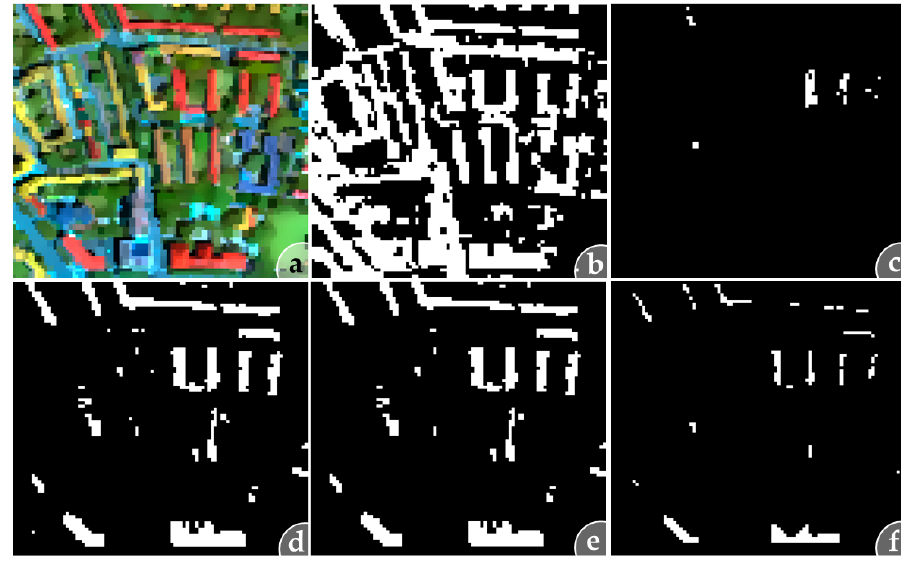
Figure 4. Masking steps to determine unknown artificial pixels for ( a ) a subset of test site D using the BSL without tiles by ( b ) separating artificial pixels from pre-classification results; ( c ) extracting dissimilar artificial pixels based on a 1% dissimilarity threshold; ( d ) enhancing the mask by a second similarity analysis to include outliers; ( e ) removing single pixels and ( f ) removing border pixels based on the von-Neumann criteria for eliminating mixed pixels.